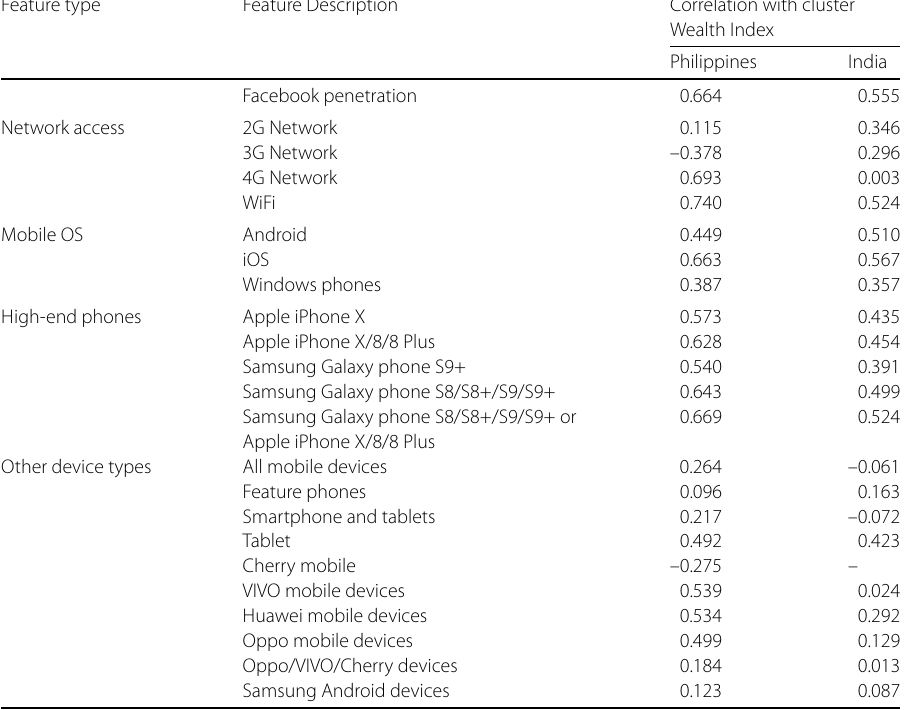
Table 2 List of features derived from the Facebook advertising audience estimate data. All features, with the exception of Facebook penetration, are the fraction of Facebook users in the targeted location who use a given network/device type to access Facebook. All data are for users aged 18+. The Facebook penetration is the number of users divided by the total population of the location; where there were more estimated users than the estimated population the value was capped at 1. Note that according to the Facebook audience estimates, of all users who use a smartphone, the percentage who do not use either of the three specified Mobile OS types (Android, iOS, Windows) are 61% (India) and 51% (Philippines); of all users, the percentage who do not use either of the four specified network types (2G, 3G, 4G, WiFi) to access Facebook are 25% (India) and 37%